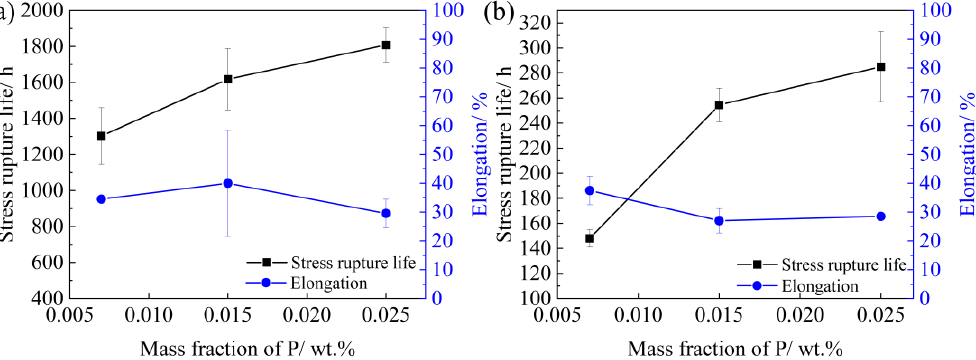
Figure 10. The stress rupture properties of 15Cr–15Ni–Ti–xP alloy after solution treated at 1120 °C for 2 h: ( a ) 650 °C/195 MPa; ( b ) 650 °C/255 MPa.